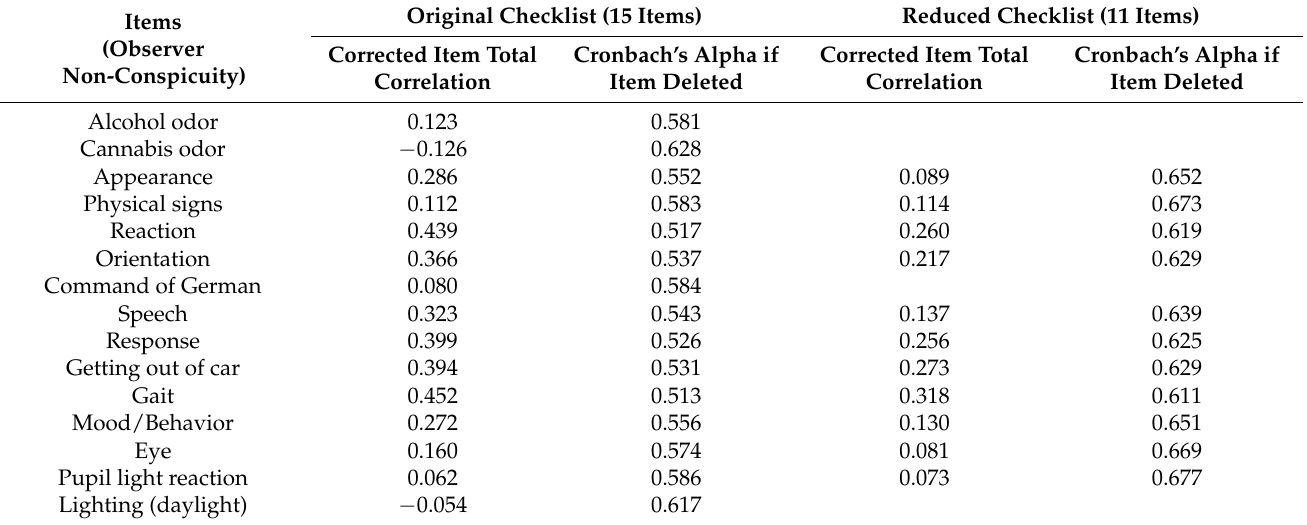
Table 1. Reliability analysis of the original checklist, including 15 items (columns 2 and 3), and of the reduced checklist after the exclusion of four items (columns 4 and 5). Pupil size estimation is not included. Cronbach’s Alpha—original checklist, 0.58; reduced checklist, 0.67. Number of checklists processed =